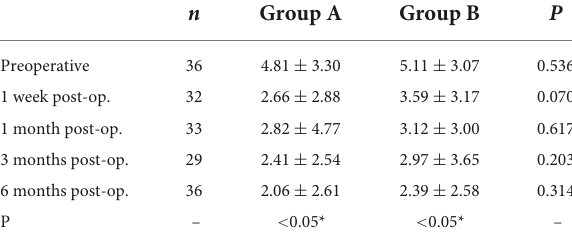
or at 1 week, 1 month, 3 months, and 6 months after SMILE.